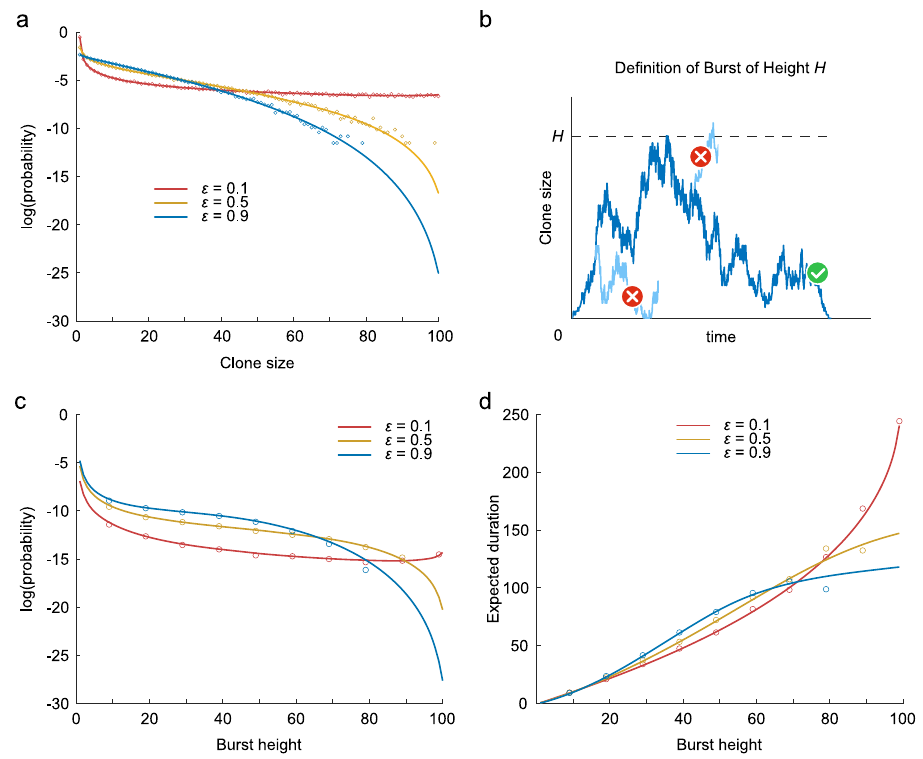
Fig. 3 Clone size distribution and clonal bursts depending on the proliferation rate of master stem cells in the hNC model. a Stationary probability distribution of clone size with different proliferation rates of master stem cells ε . The solid line and dots indicate the probability distributions derived through mathematical analysis (equation [7]) and numerical simulation, respectively. b De fi nition of clonal bursts. A burst of height H is de fi ned as the dynamics in which the clone size changes from 0 to H without returning to 0, and then returns to 0 without reaching H + 1. c Probability of burst generation of each height H starting at clone size 0 depending on the proliferation rates of master stem cells ε . Solid lines indicate the analytical solution for the probability (equation [15]). Dots indicate the probability calculated by numerical simulation. d Expected duration of a clonal burst of each height H starting at clone size 0 depending on the proliferation rates of master stem cells ε . Solid lines indicate the analytical solution of the expected duration (equation [22]). Dots indicate the average duration of a clonal burst of each height calculated by the numerical